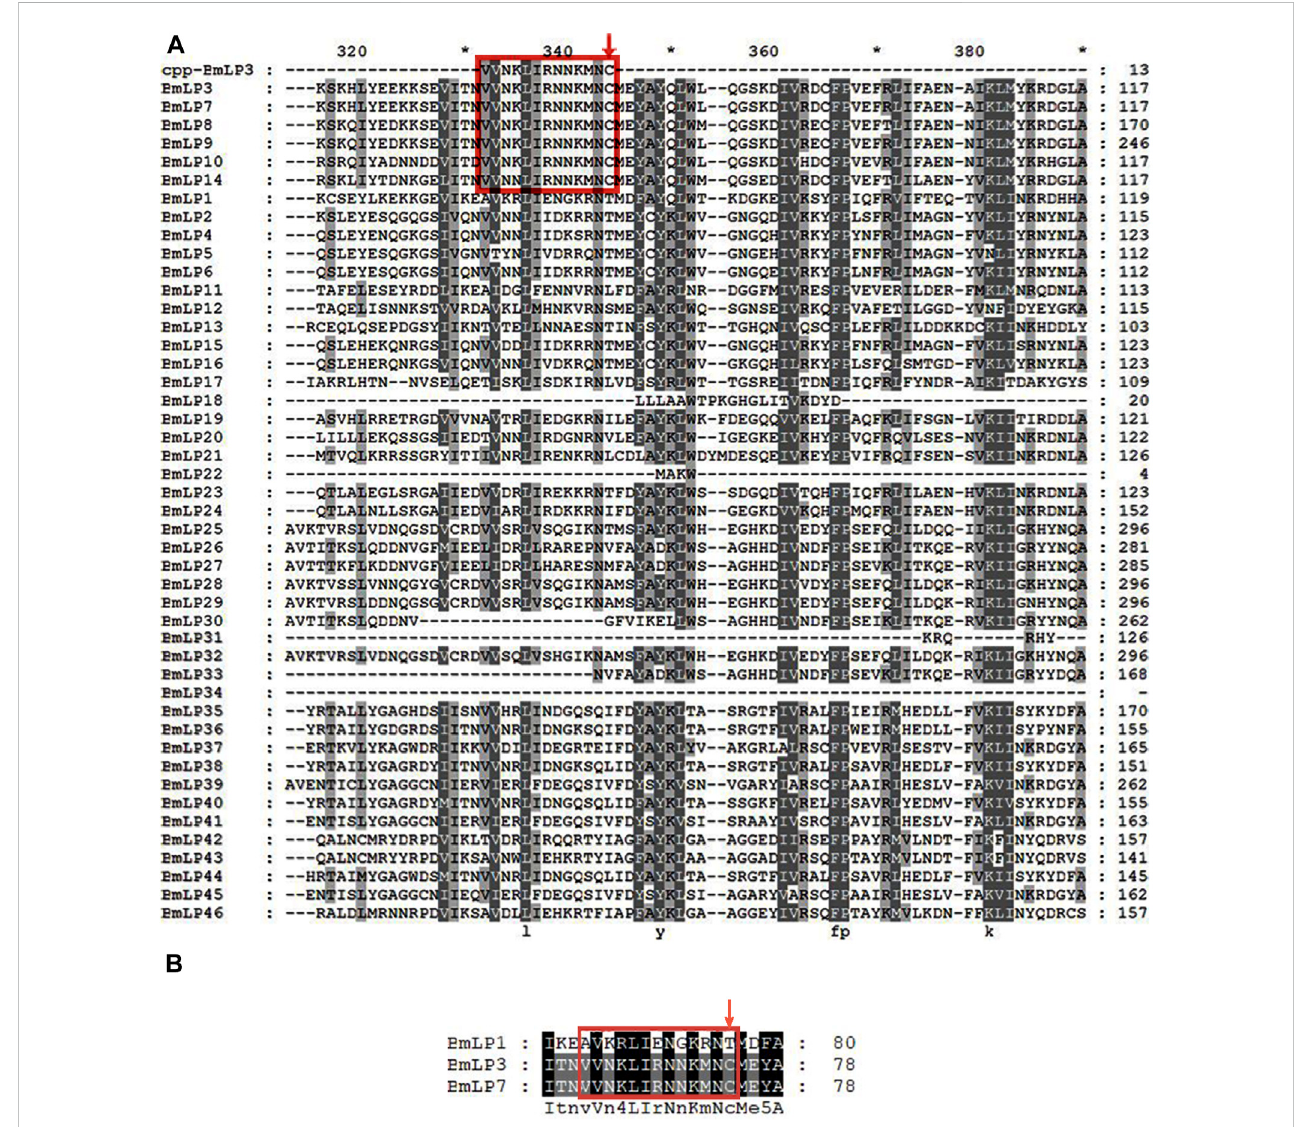
FIGURE 1 Sequence analysis of30 K proteins insilkworm. (A) Alignmentof46 types ofsilkworms30 Kproteins using Clustalx1.83and GENEDOC. (B) Alignmentof partial amino acid residues of BmLP1, BmLP3, and BmLP7 using Clustalx1.83 and GENEDOC. 30 K protein sequences were downloaded from the Silkworm Genome Database (http://silkdb.bioinfotoolkits.net/). Residues in the red box represent the common CPP domain in partial 30 K proteins, including BmLP3 and BmLP7. The red down arrow indicates the conserved domain of 30 K proteins consistent with the Cysteine position of the CPP domain of